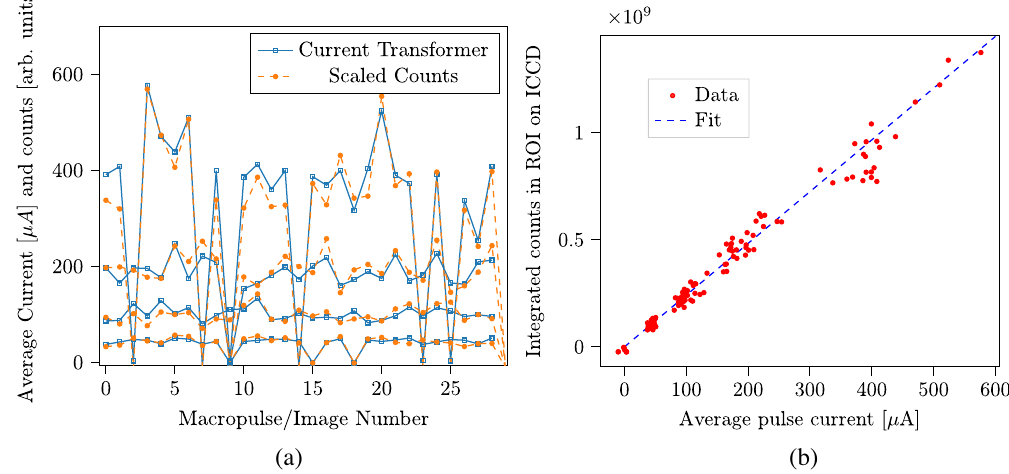
FIG. 9. (a) Macropulse average current vs integrated count per image in the region of interest. A linear behavior from 40 μ A to 600 μ A (b) Current transformer reading vs integrated counts on consecutive images for the four current